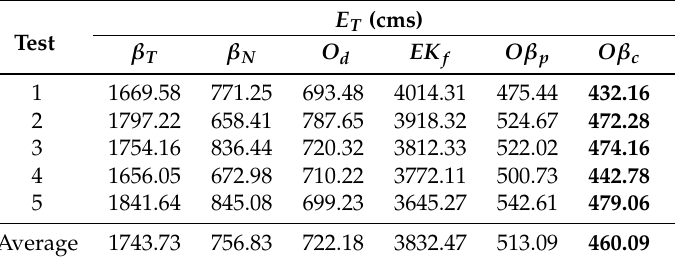
Table 4. Localization error for Trajectory 2. The least error for each row is written in